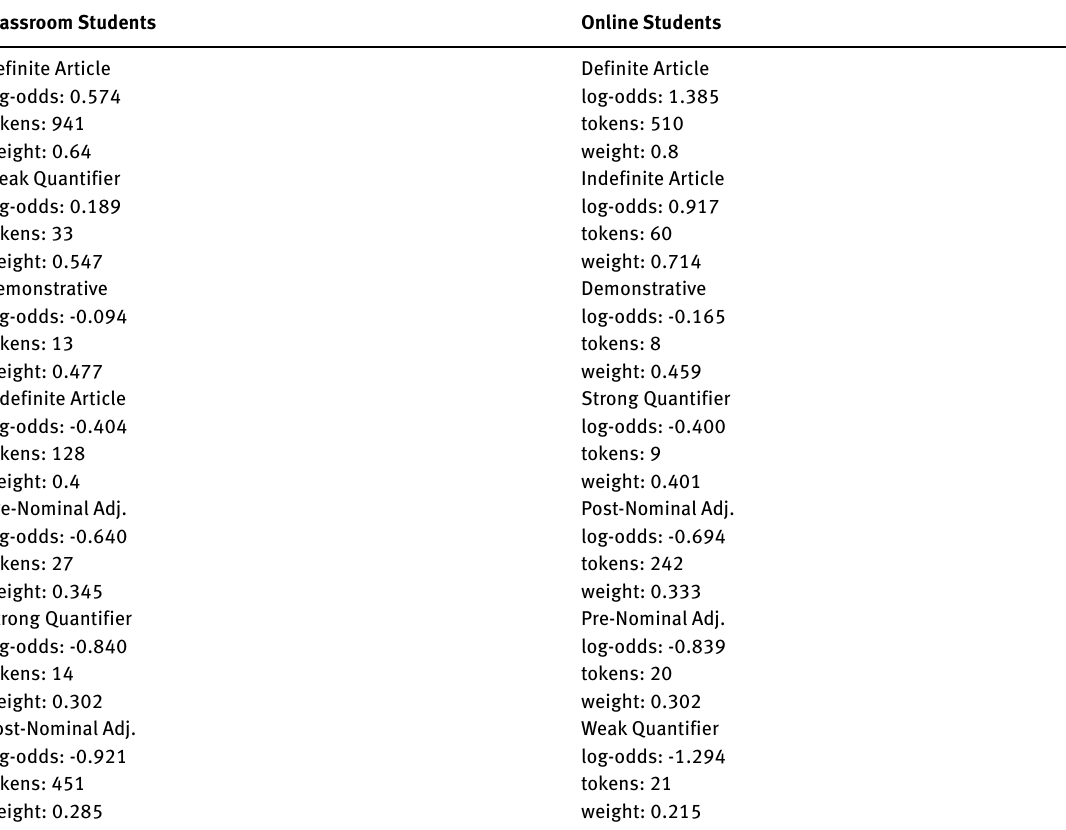
Table 6. Grammatical hierarchy of agreeing words affecting accurate Spanish gender agreement in Beginning Students of Spanish.